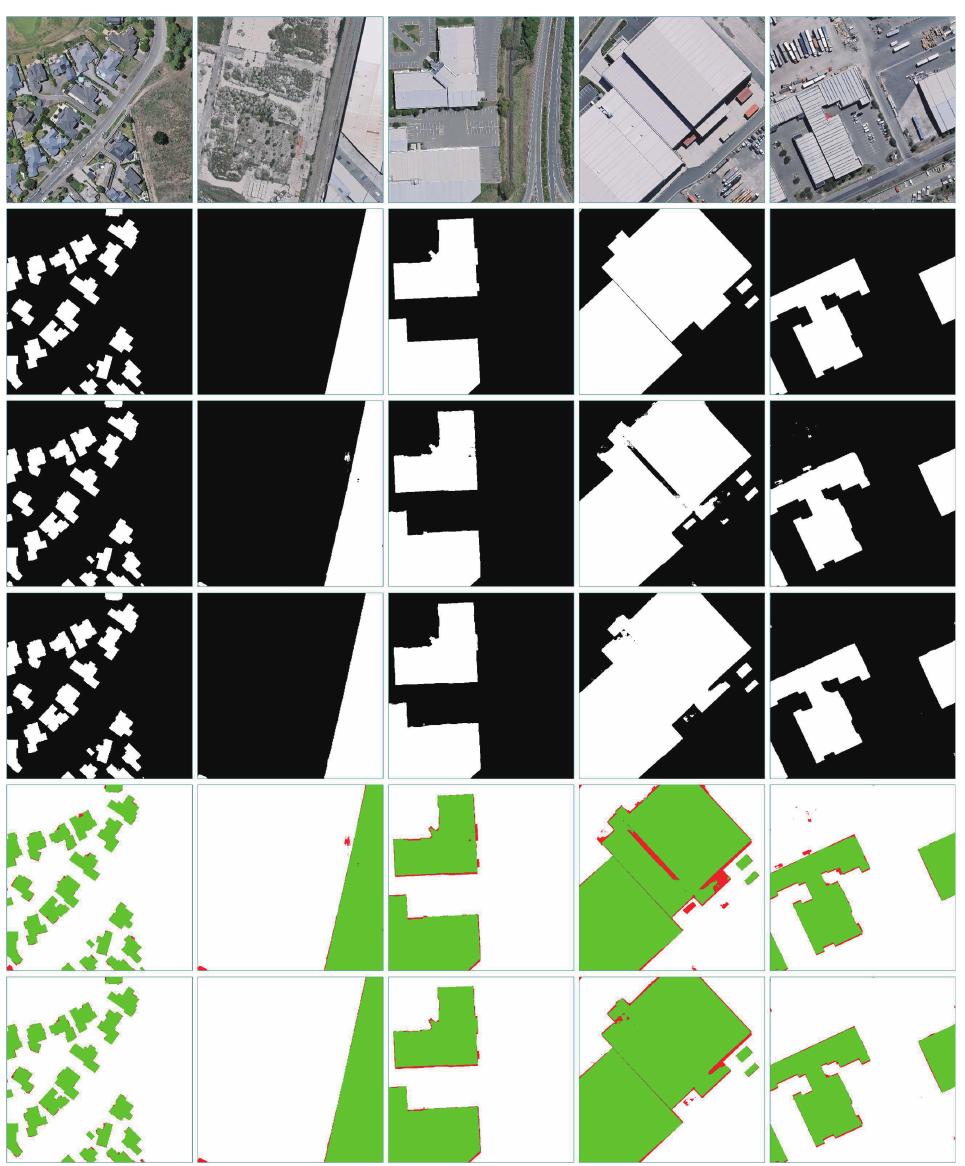
Figure 7. Examples of building extraction results produced by our method and U-Net on the WHU Aerial Building Dataset. The first two rows are aerial images and the ground truth. The predictions by U-Net and our method are in row 3 and row 4, respectively. The last two rows show the errors (wrongly predicted pixels are marked in red) of U-Net and our method, respectively.